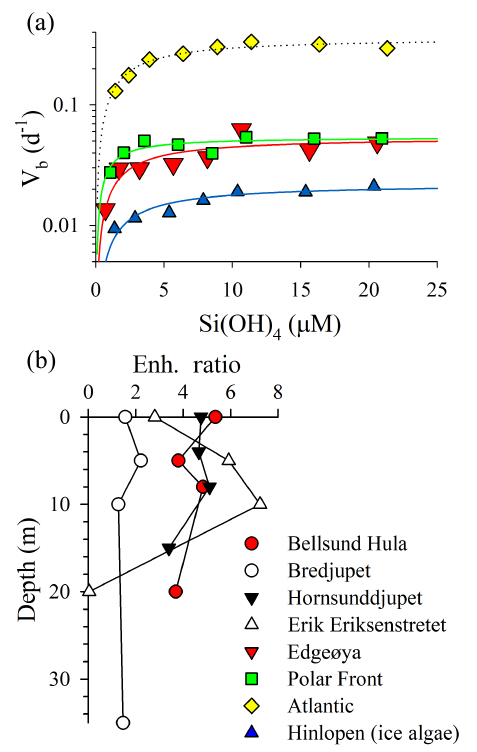
Figure 4. Assessment of Si uptake limitation by available silicic acid during ARCEx. (a) Eight-point kinetic experiments taken at four stations (legend next to b ). Data were fit to a Michaelis–Menten hyperbola using SigmaPlot 12.3 software. (b) Enh. ratio profiles (i.e., V b in + 18 . 0µM [Si ( OH ) 4 ] treatment relative to V b in the am- bient [Si ( OH ) 4 ] treatment) at four